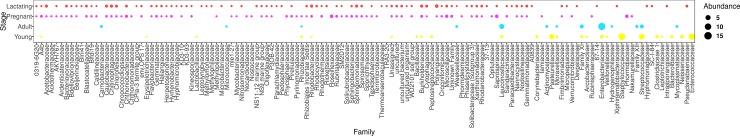
Linear discriminant analysis (LDA) effect size (LEfSec) showing similarities in the microbial communities of L. yerbabuenae at the family level.